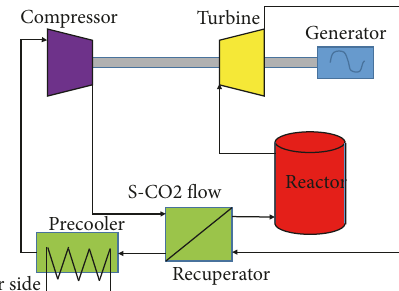
Figure 1: Schematicmap of nuclearreactorsystem cooled by s-CO2 Brayton